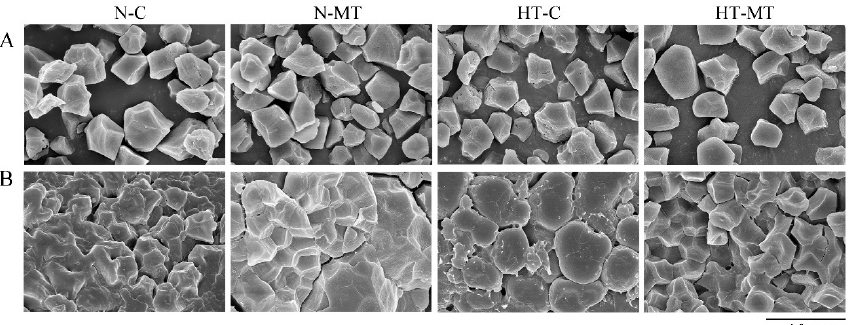
Figure 3. SEM observation of starch granule ( A ) and grain cross-section ( B ) of NPB grown at different temperatures. “N” and “HT” indicate normal and high temperature conditions. “C” and “MT” indicate H 2 O and melatonin treatment, respectively.